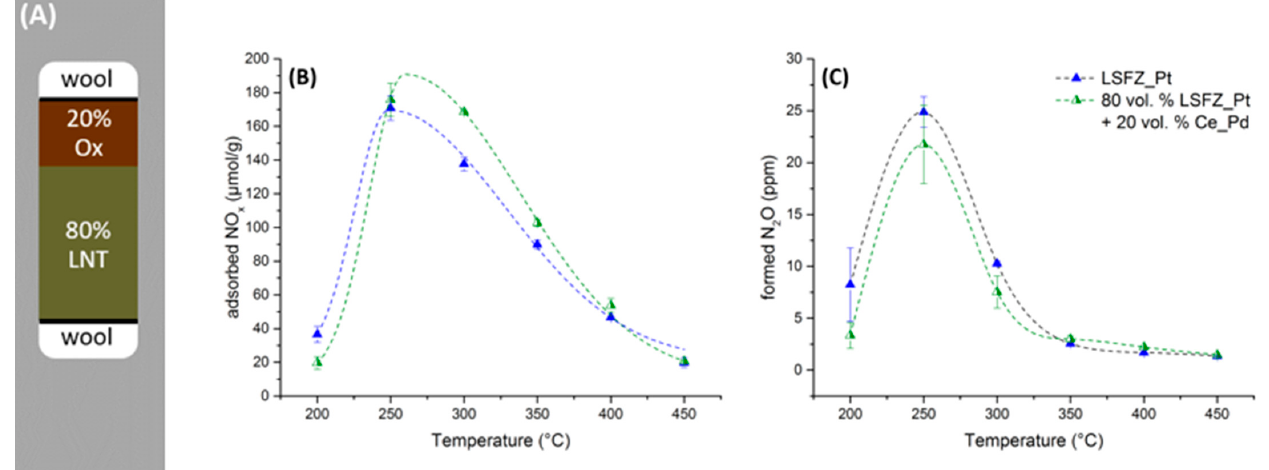
Figure 5 . ( A ) Scheme of the filling constitution for the top-layered oxidation catalyst-LNT combination. Comparison of the temperature dependent NO x storage capacity ( B ) and N 2 O formation ( C ) for LSFZ_Pt ( ▲ , from reference [44]) and a catalyst combination of 80 vol. % LSFZ_Pt covered with 20 vol. % of Ce_Pd ( ).